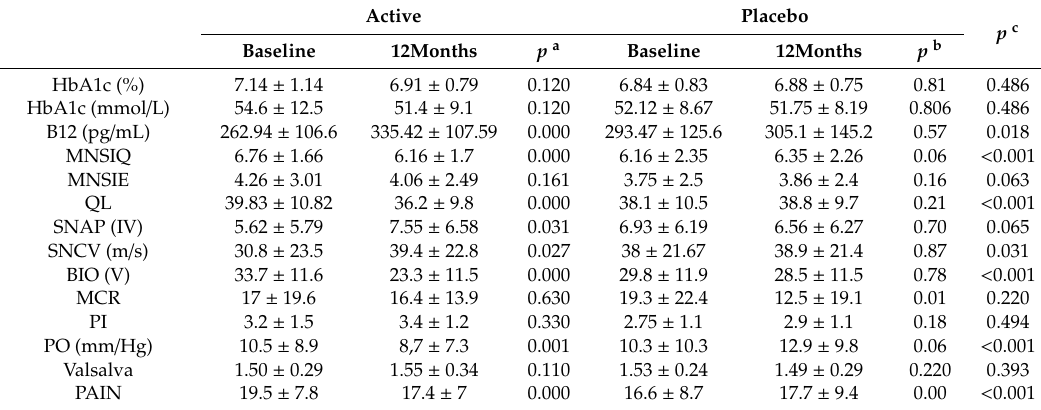
Table 4. Changes in indices from baseline to end of intervention for both groups.